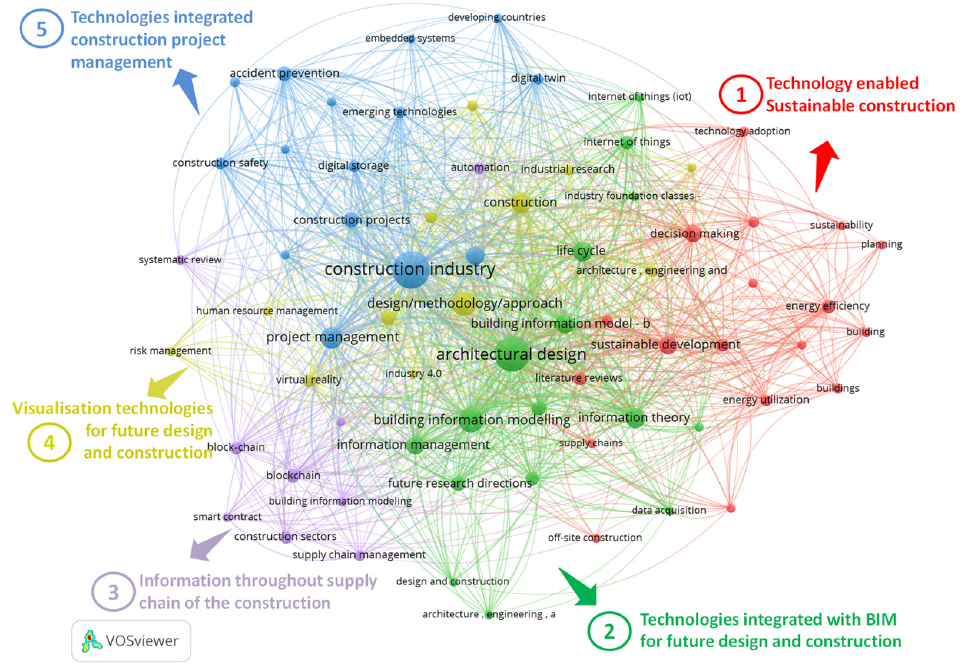
Figure 3. Science mapping keyword analysis of retrieved articles.